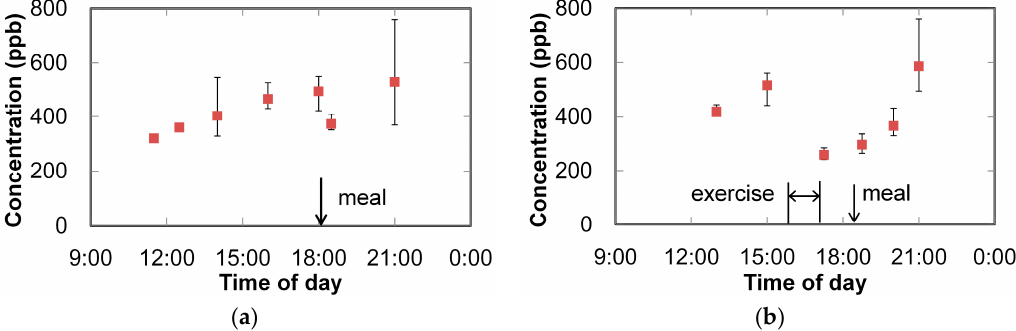
Figure 12. Change in measured concentration of isoprene in breath (of two examinees) during the day: ( a ) effect of eating; ( b ) effect of exercise.